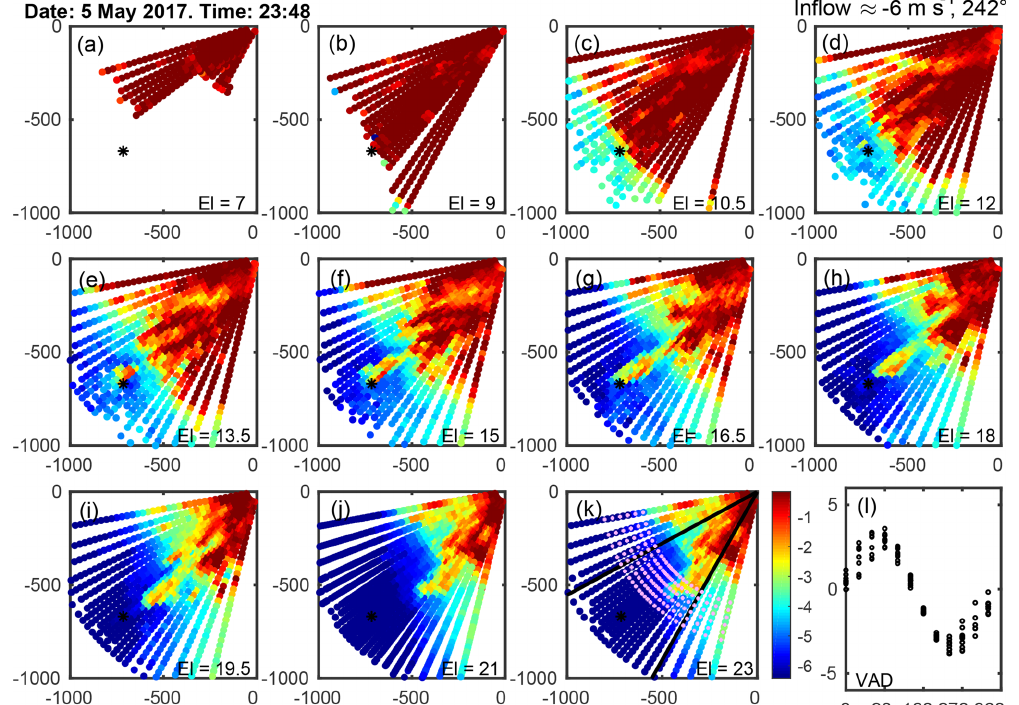
Figure 5. Example of arc scans from 5 May 2017 at 23:48 (UTC). During this 10min period the sonic anemometer at 78ma.g.l. on Tower 20 indicated a wind speed of 5.9ms − 1 and a wind direction of 252 ◦ , stable stratification with z/L = 2 . 27, and TI = 0.05. Data from the VAD scans (l) indicated a wind direction of ∼ 240 ◦ . Conditions upstream of the wind turbine as characterized by the arc scans are 6.0ms − 1 and 242 ◦ . Each panel is 1000m by 1000m, with the Galion located at (0, 0), and depicts line-of-sight (radial) wind speeds from each elevation angle: 7, 9, 10.5, 12, 13.5, 15, 16.5, 18, 19.5, 21 and 23 ◦ . The wind turbine location is shown by the black *, and panel (k) shows the location of the slices used in the wake characteristic quantification, shown as the magenta arcs at 2, 2.5, 3, 3.5, 4 and 4.5 D downstream of the wind turbine, as well as the wake directions 209–241 ◦ , shown by the thick black